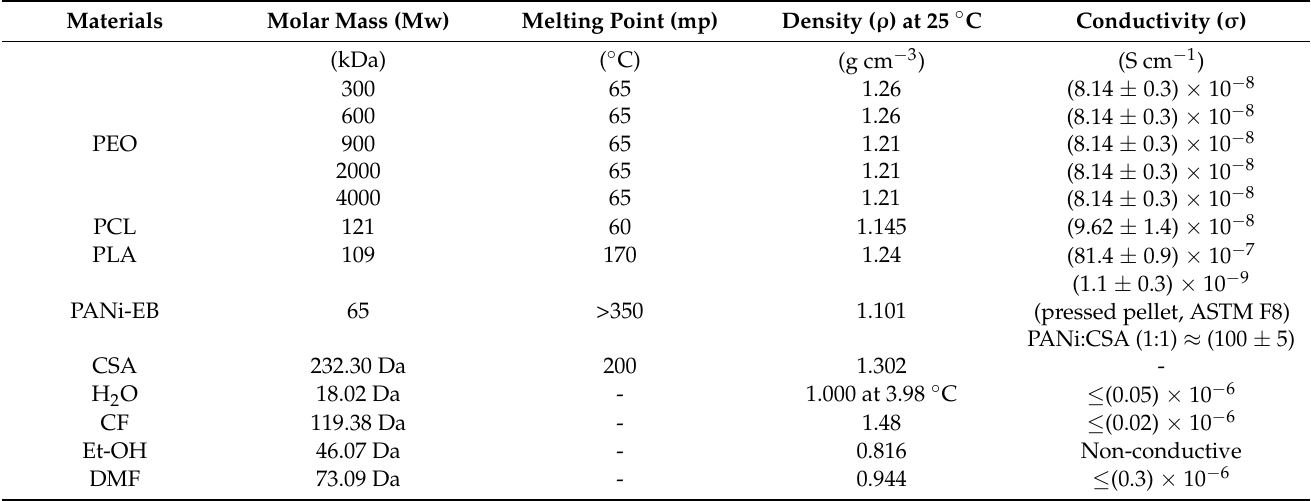
Table 1. Characteristics and properties of materials